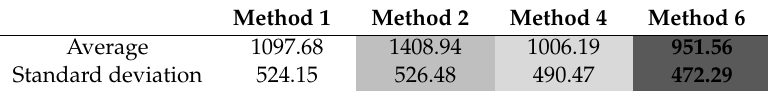
Table 8. Results of root mean square error (RMSE), by methods.